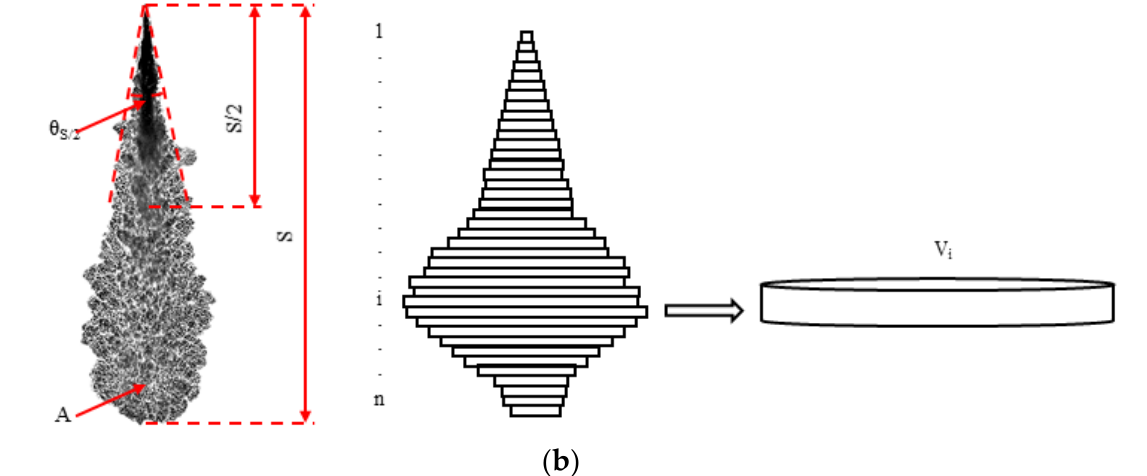
Figure 3. Method of image processing. ( a ) Morphology analysis of evaporating spray. ( b ) Definition of spray parameters.